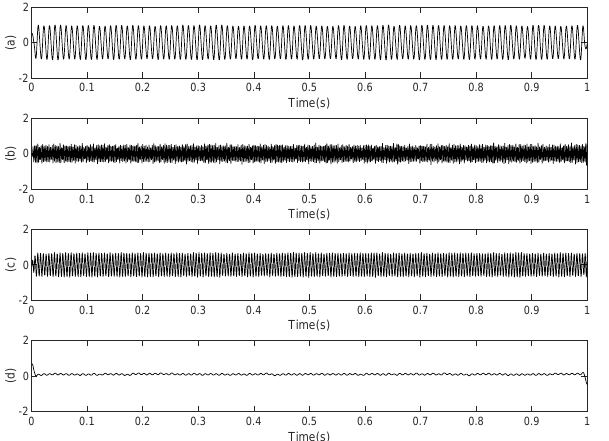
Figure 3. The IMF components 1–4 ( a – d ) of the mixed signal after VMD when [ K , α ] = [4,